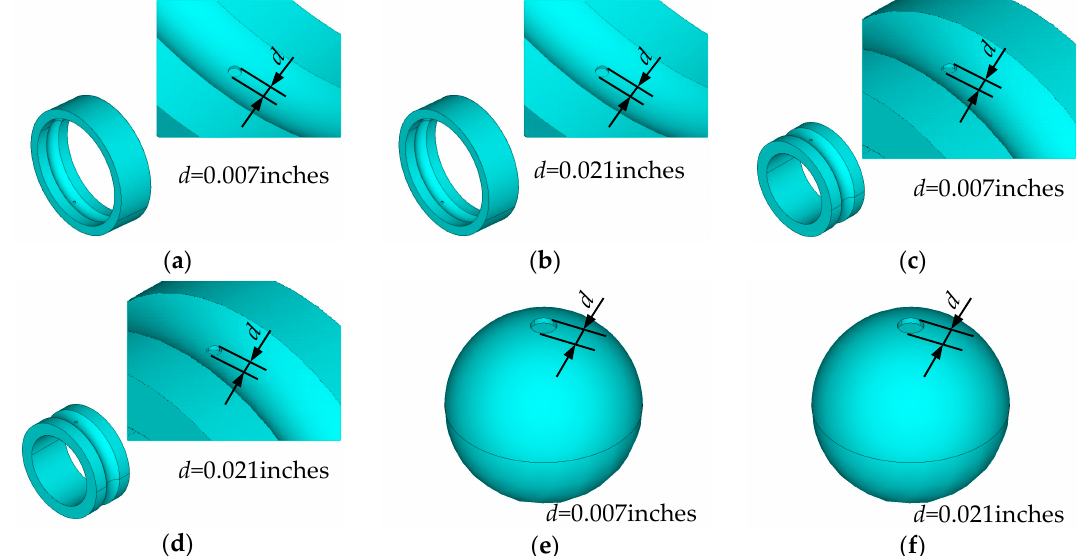
Figure 5. The geometry of faulty bearing: ( a ) Fault type T 1 ; ( b ) Fault type T 2 ; ( c ) Fault type T 3 ; ( d ) Fault type T 4 ; ( e ) Fault type T 5 ; and ( f ) Fault type T 6.